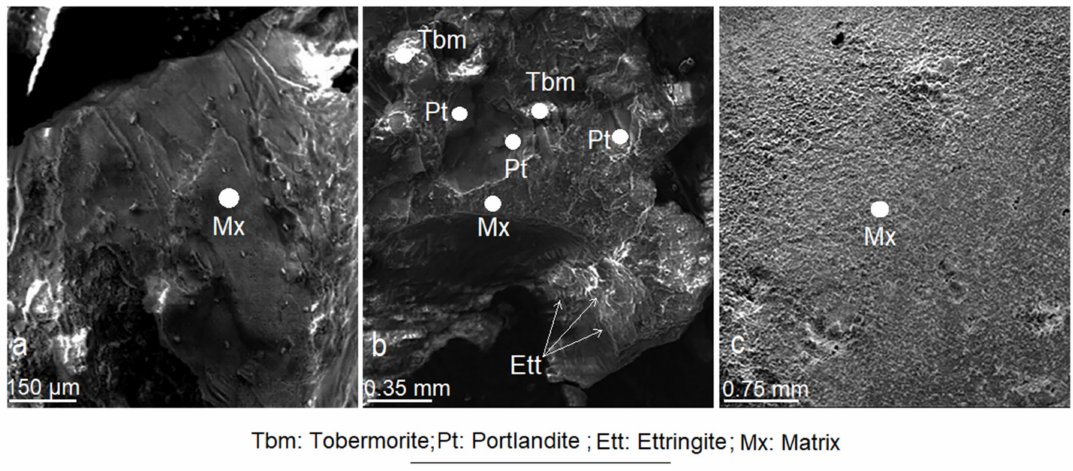
Figure 16. ( a – c ). Microphotographs of cement/mordenite specimens (CMS) taken at 90 days of age.